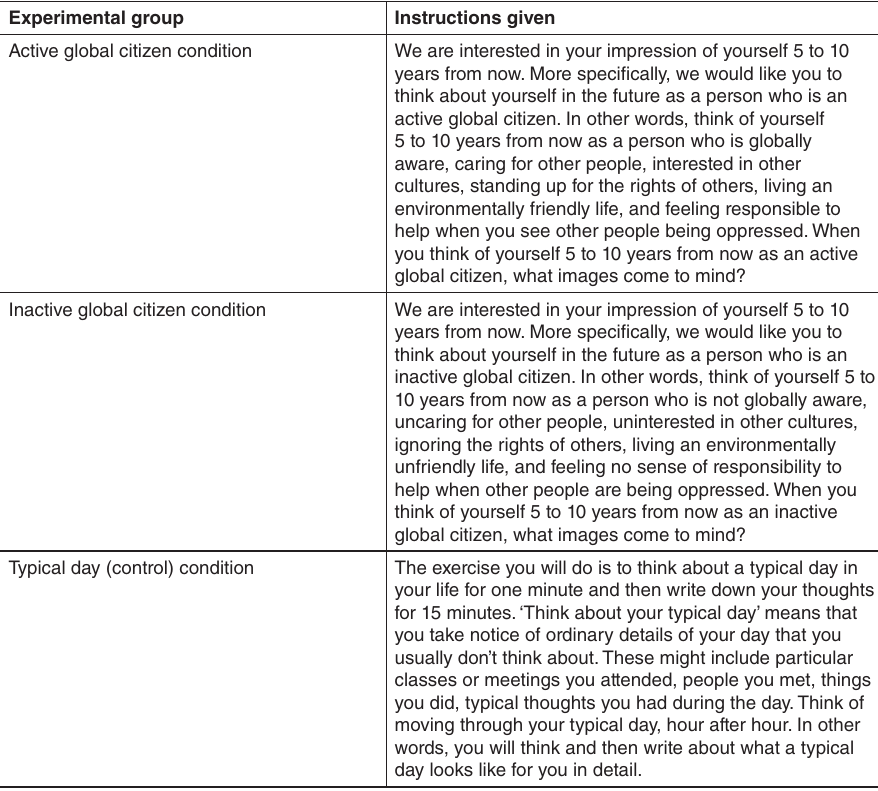
Table 1: ‘Possible self’ manipulation instructions Experimental group Instructions